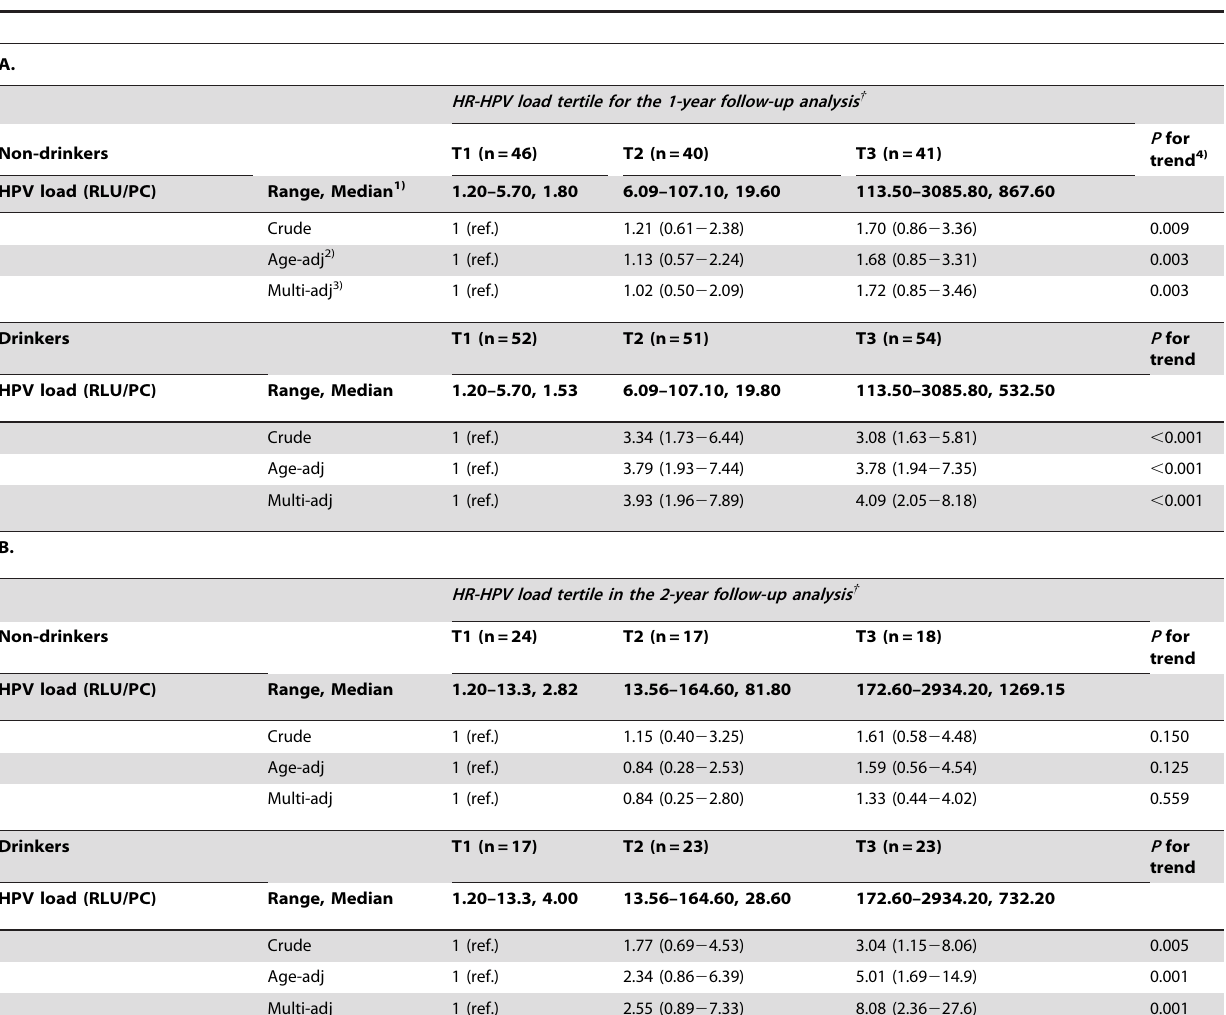
Table 3. Odds ratios and 95% confidence intervals for the risk of high risk-human papillomavirus (HR-HPV) infection among non- drinkers and drinkers according to the HR-HPV load